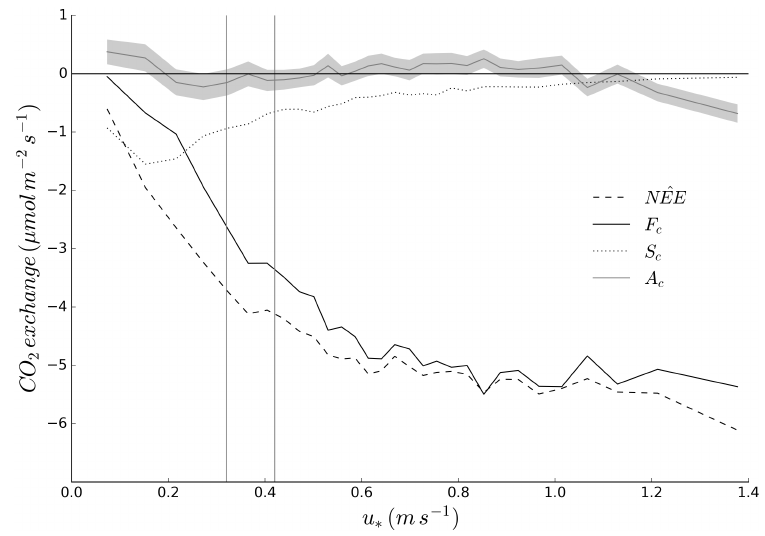
Figure 8. Dependence of measured ( F c ,S c ), model-estimated ( d NEE ) and inferred ( A c ) mass balance components on friction velocity ( u ∗ , the grey shaded area represents the 95% confidence interval for the sample bin mean of the inferred advection components). Vertical lines denote u ∗ th for both F c and F c + S c , as per Fig.